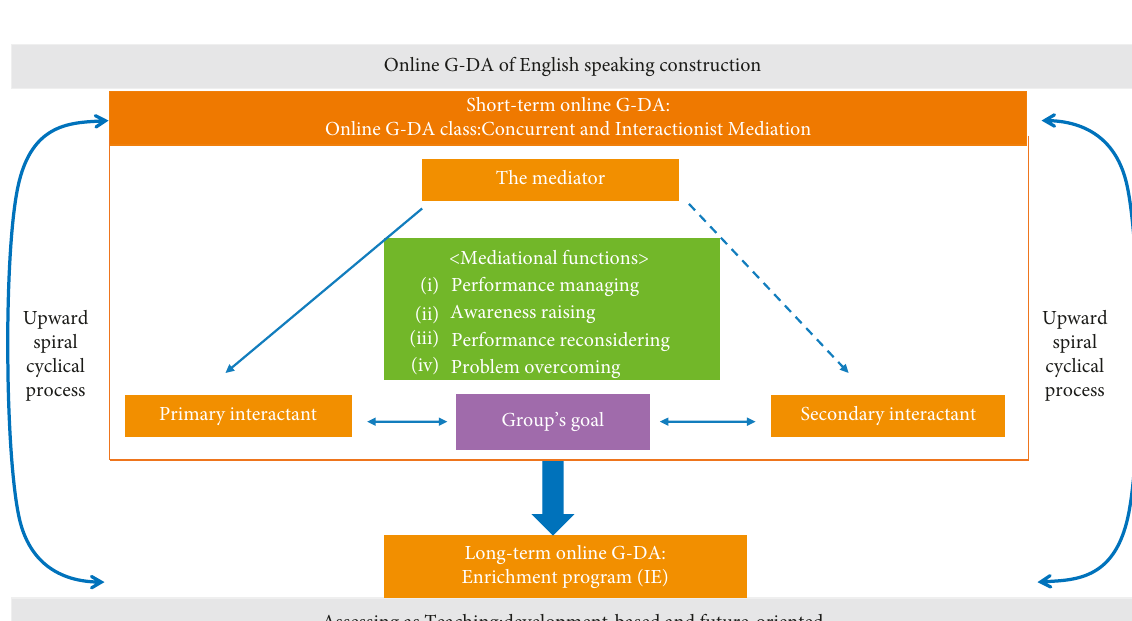
Figure 5: Online G-DA of college English speaking